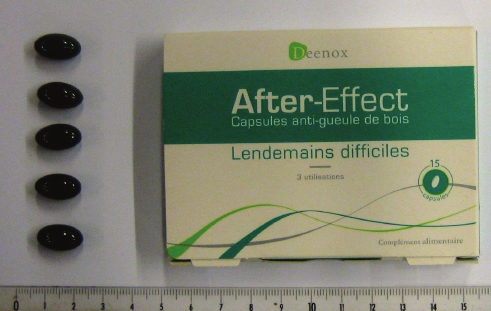
Figure 2: After-E ff ect © : package and capsules. Three capsules should be taken before alcohol consumption and two additional capsules before going to